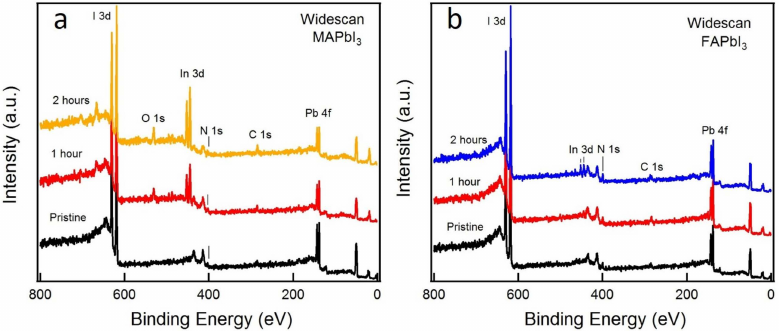
Figure 3. XPS wide scans obtained from MAPbI 3 and FAPbI 3 samples before and after water vapor exposure. ( a ) MAPbI 3 sample; ( b ) FAPbI 3 sample.